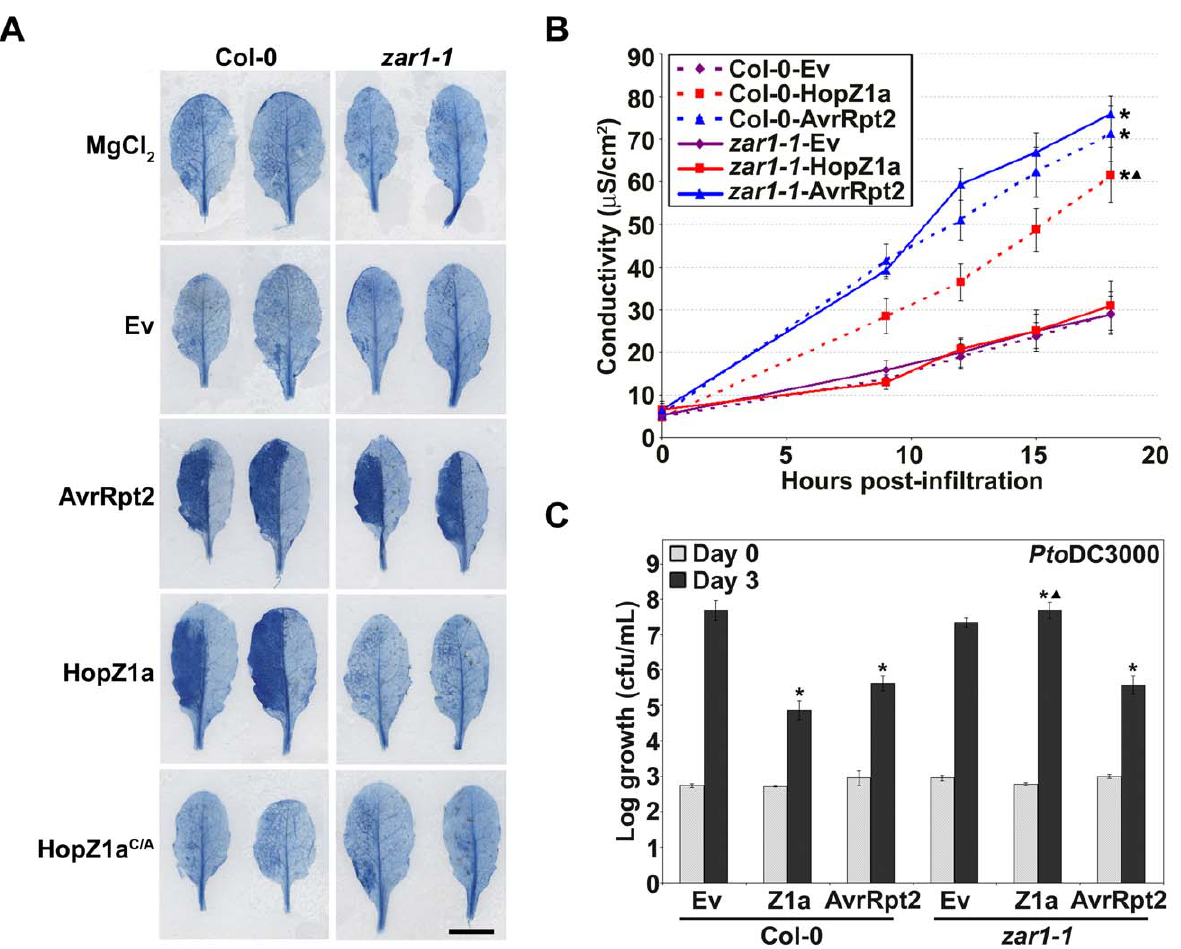
Figure 3. zar1-1Arabidopsis plants do not display immunity against HopZ1a. (A) Trypan blue staining of Pto DC3000-infiltrated Arabidopsis Col-0 or zar1-1 leaves. The bacteria were syringe infiltrated into the leaves at 5 6 10 7 cfu/mL. Scale bar is 1 cm. C/A indicates the C216A mutation of HopZ1a in the predicted catalytic triad. The mutant protein is expressed at a similar level to HopZ1a [39]. (B) Electrolyte leakage of Arabidopsis Col-0 or zar1-1 leaf discs after infiltration with Pto DC3000 expressing the indicated constructs. The bacteria were syringe infiltrated into the leaves at 2 6 10 7 cfu/mL. Error bars indicate the standard deviation from the mean of 6 samples. C/A indicates the C216A mutation. Two-tailed homoschedastic t-tests were performed to test for significant differences. Within a plant genotype, treatments were compared to empty vector and significant differences are indicated by an asterisk (* P , 0.01). To compare between plant genotypes, ion leakage from Pto DC3000 carrying HopZ1a or AvrRpt2 was normalized to the average ion leakage of Pto DC3000(Ev) in the same genotype. Significant growth differences between zar1-1 and wild-type Col-0 are indicated by a triangle ( m P , 0.01). (C) Pto DC3000 expressing the indicated construct was syringe infiltrated at 1 6 10 5 cfu/mL into Arabidopsis Col- 0 or zar1-1 leaves and bacterial counts were determined one hour post-infection (Day 0) and 3 days post-infection (Day 3).